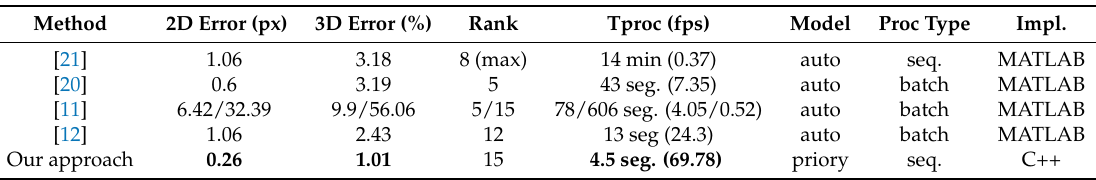
Table 3. CMUfacesequence results summary. Some results comparing different state-of-the-art methods against the presented one are